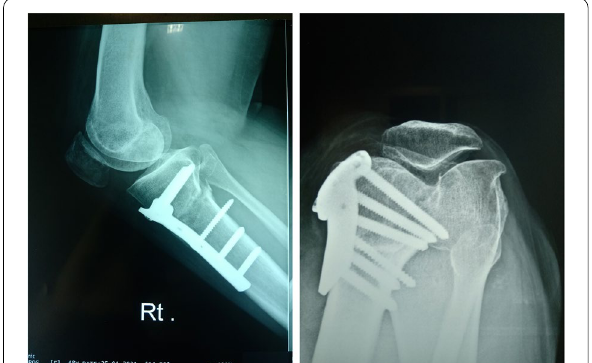
Fig. 10 Postoperative x‑ray: skyline and lateral